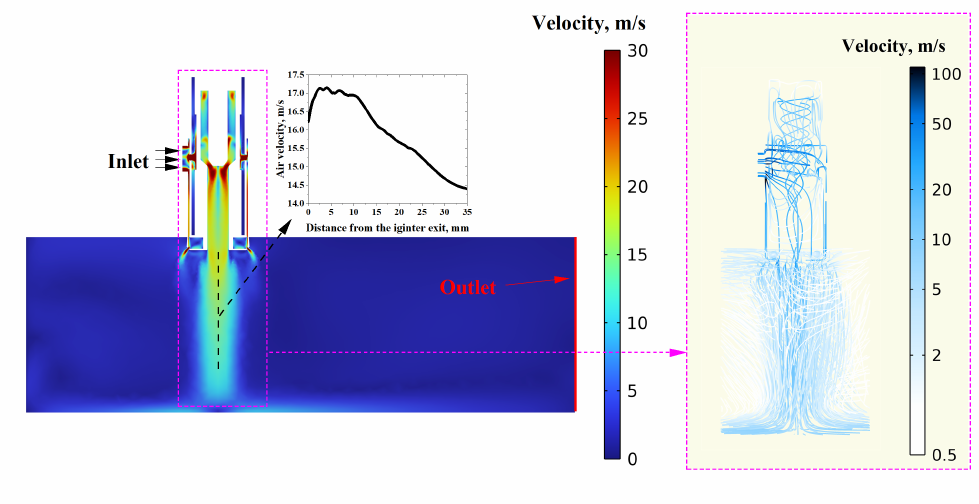
Figure 8. Air velocity of the igniter and the lower cavity with a pressure difference of 45 Torr. The slice view of the igniter is shown on the left and the streamline diagram is shown on the